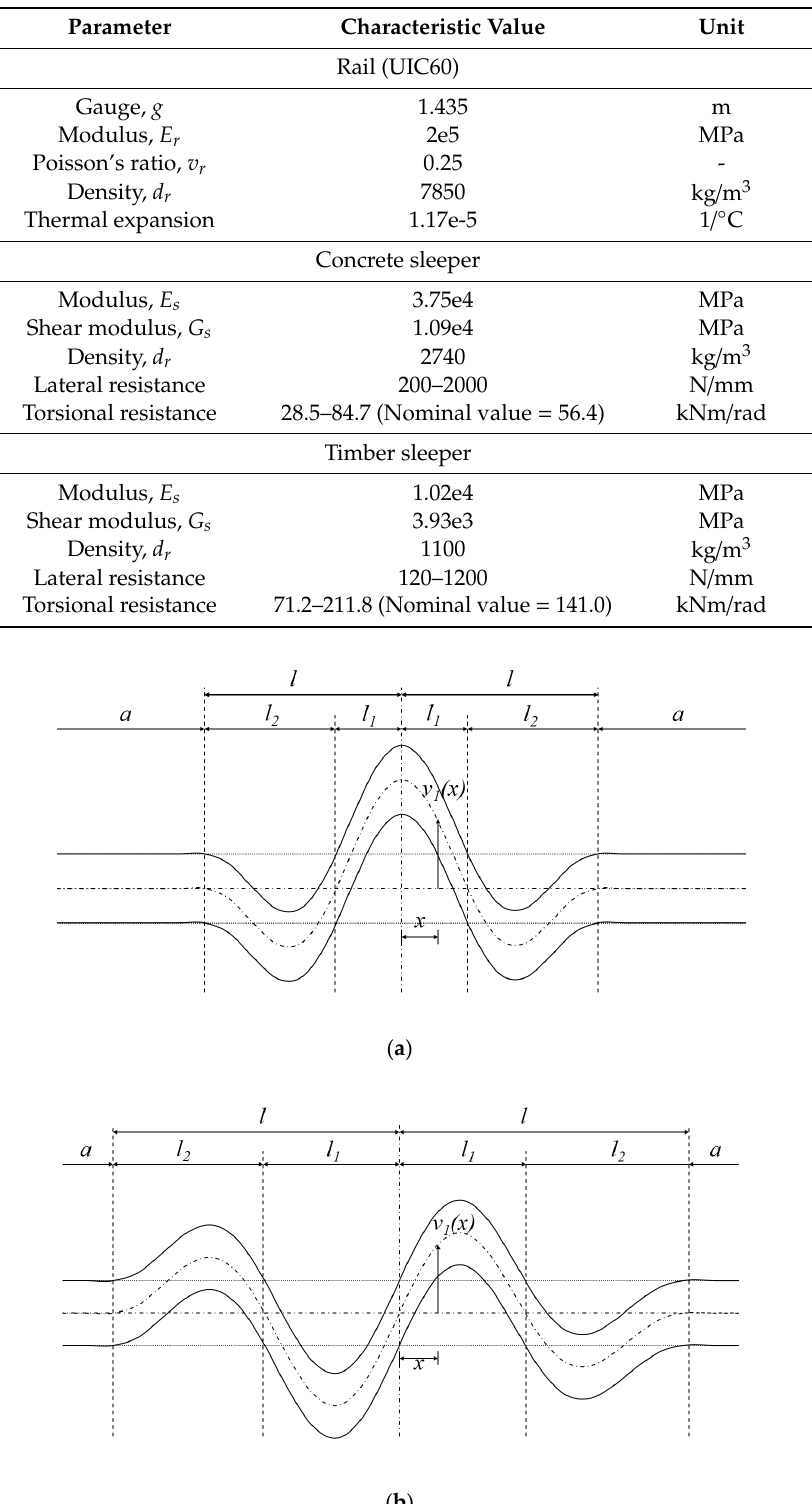
Table 1. Material properties.